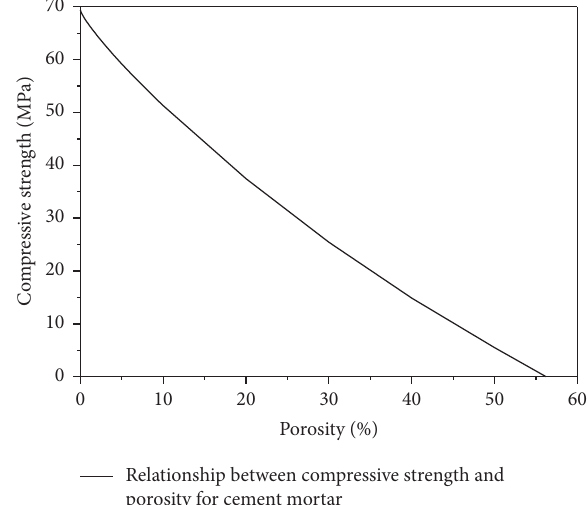
Figure 3: Relationship between compressive strength and porosity for cement